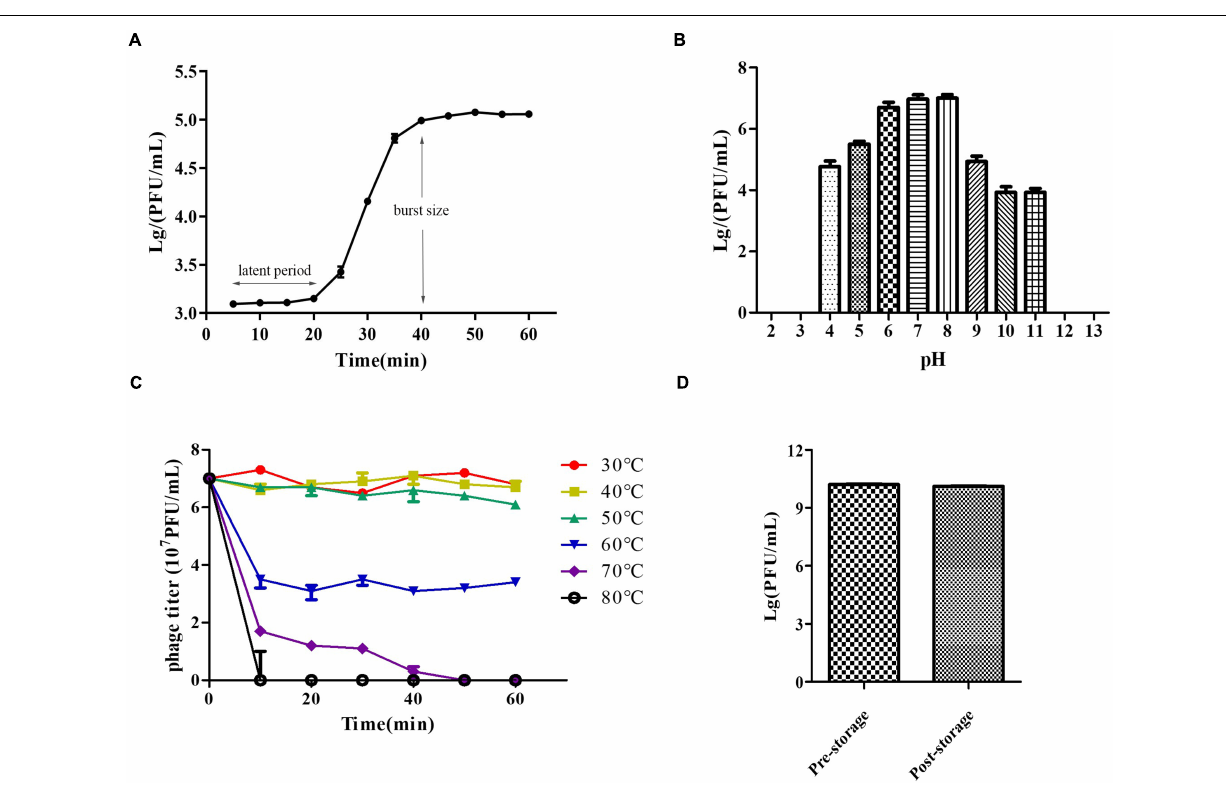
FIGURE 2 | Growth characteristics and stability tests of PZL-Ah152. (A) One-step growth curve of PZL-Ah152. (B) pH stability: PZL-Ah152 were incubated under different pH values. (C) Thermal stability: phage particles were incubated at different temperatures as indicated. (D) Long-term storage stability: the titer of pre-storage and post-storage (for 1 year) of